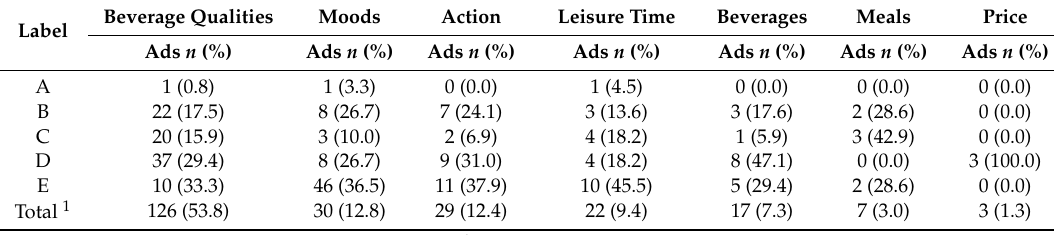
Table 4. Nutri-score classification of the advertising keywords by semantic